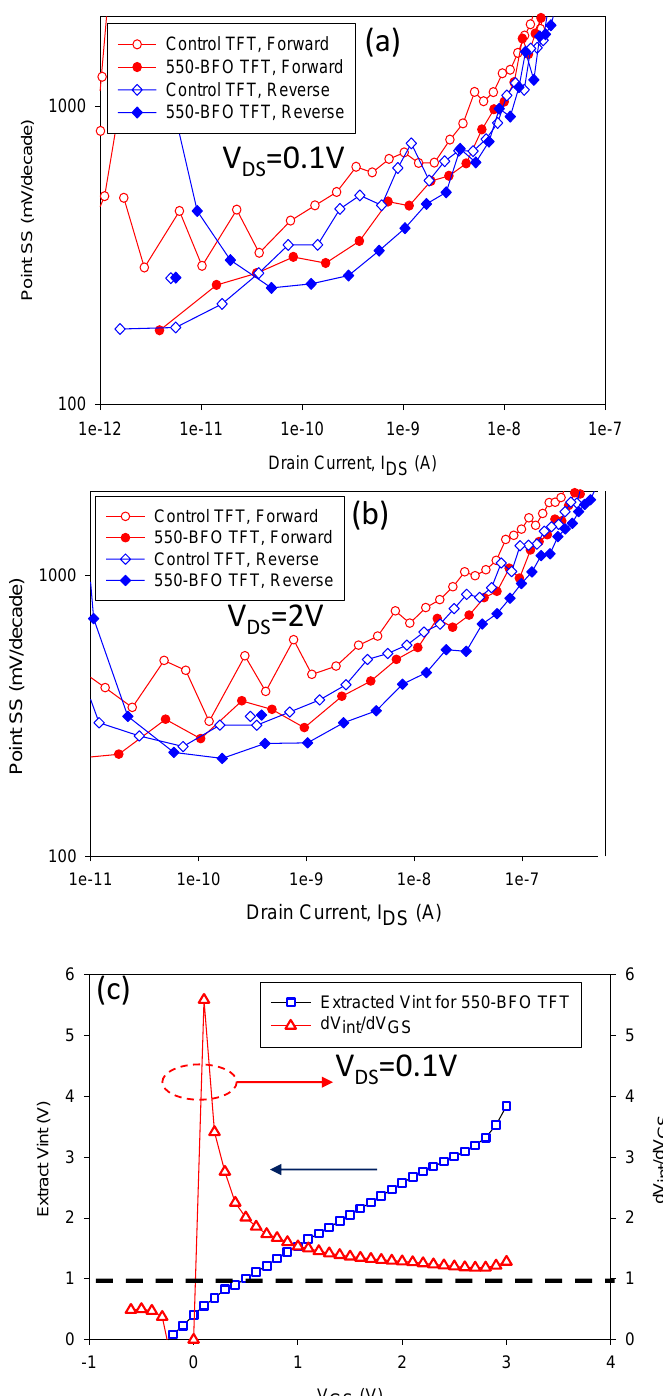
Figure 5. Point SS versus I DS curves for ( a ) control TFT (L = 5 μm, Weff = 60 nm) and 550-BFO TFT at V DS of 0.1 V and ( b ) at V DS of 2 V. ( c ) Extracted Vint and dVint/dV GS versus V GS at V DS of 0.1 V. The position of V GS and V int are marked in Figure 1h.